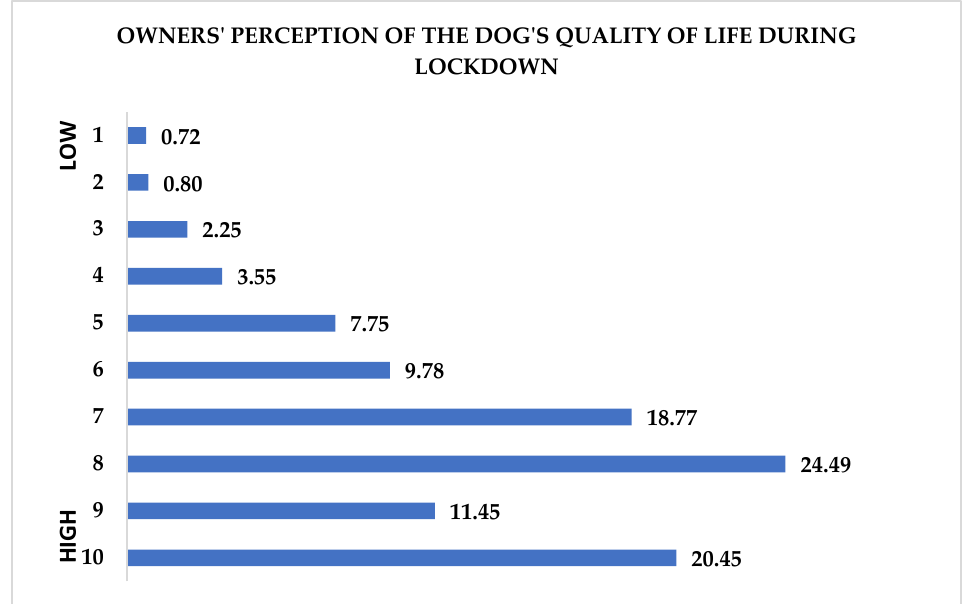
Figure 6. How the owners perceived their dogs’ quality of life. The sample responded in relation to a scale from 1 to 10, where 1 corresponded to “low quality” and 10 to “high quality” of life. Data are expressed in percentage.